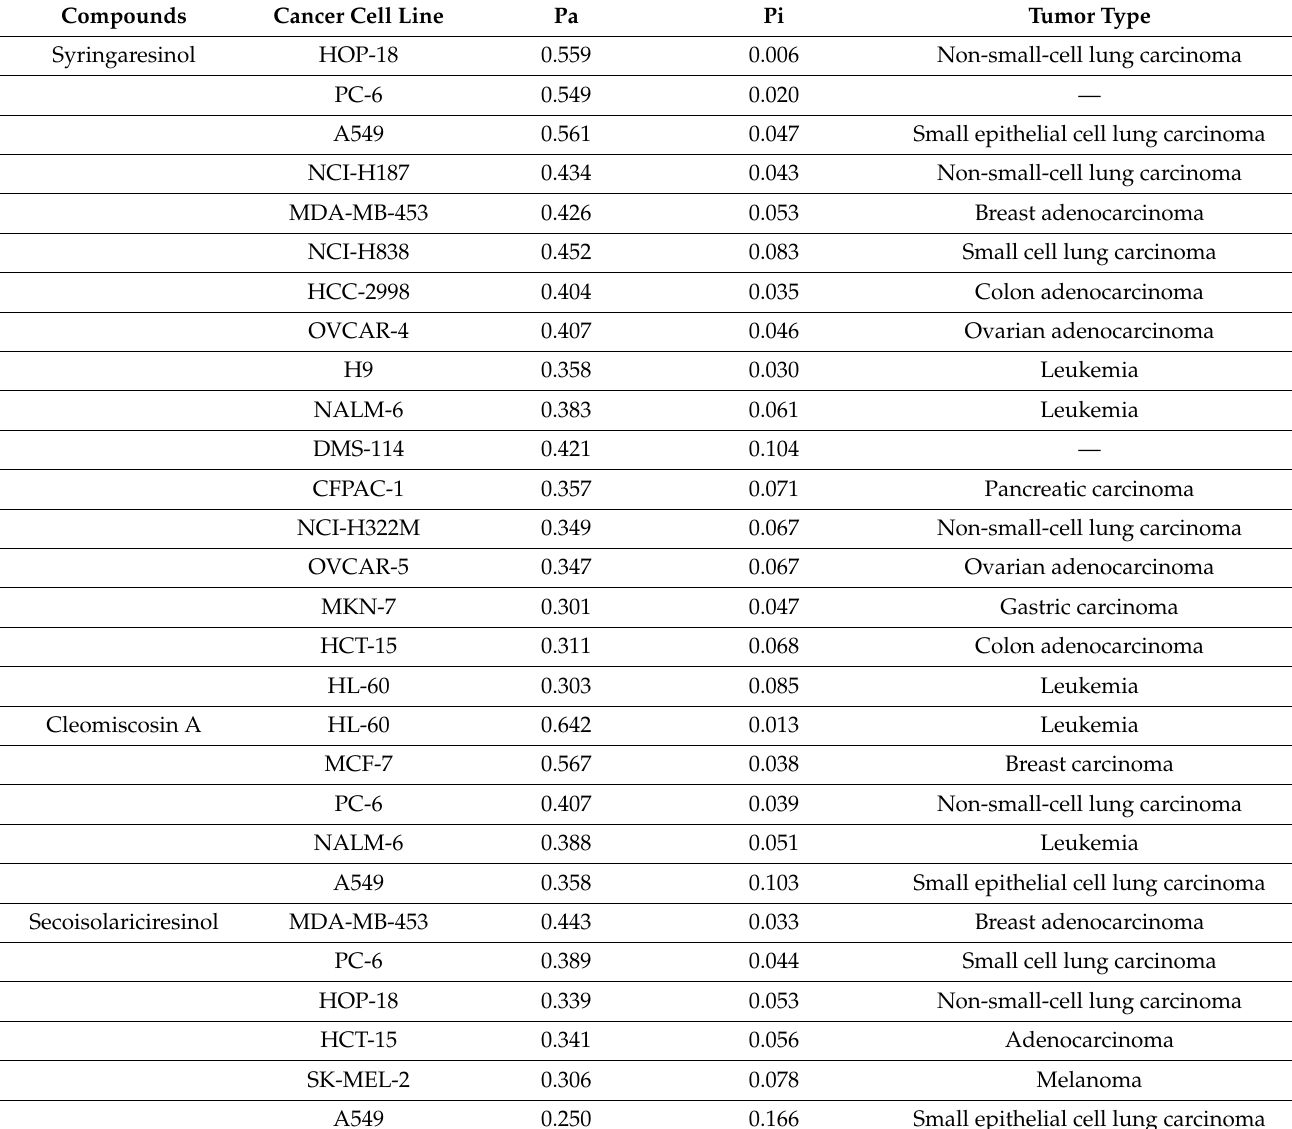
Table 4. In silico cytotoxicity prediction of selected